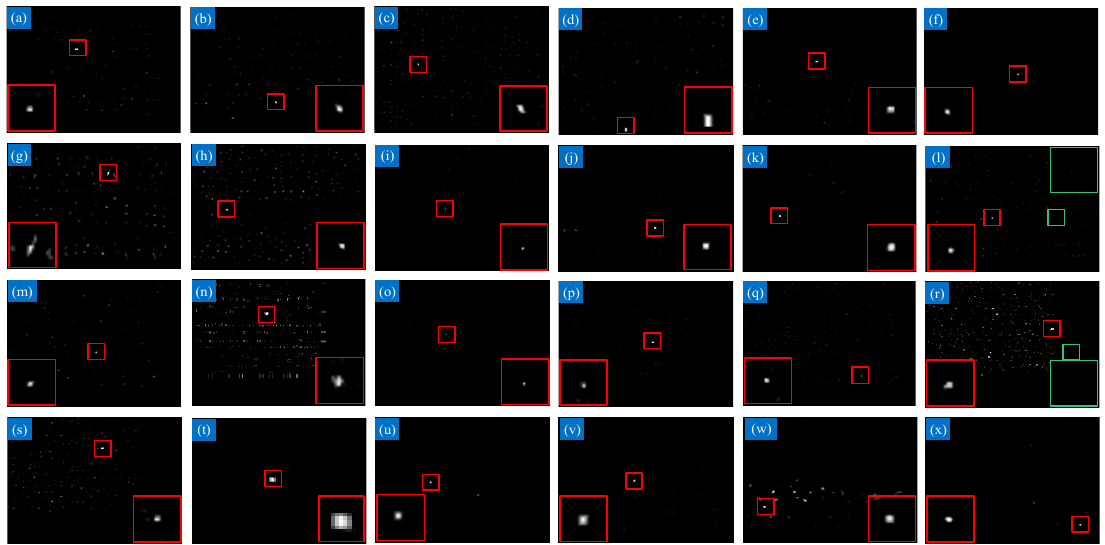
Figure A3. The separated target images of MPCM under 24 scenes.